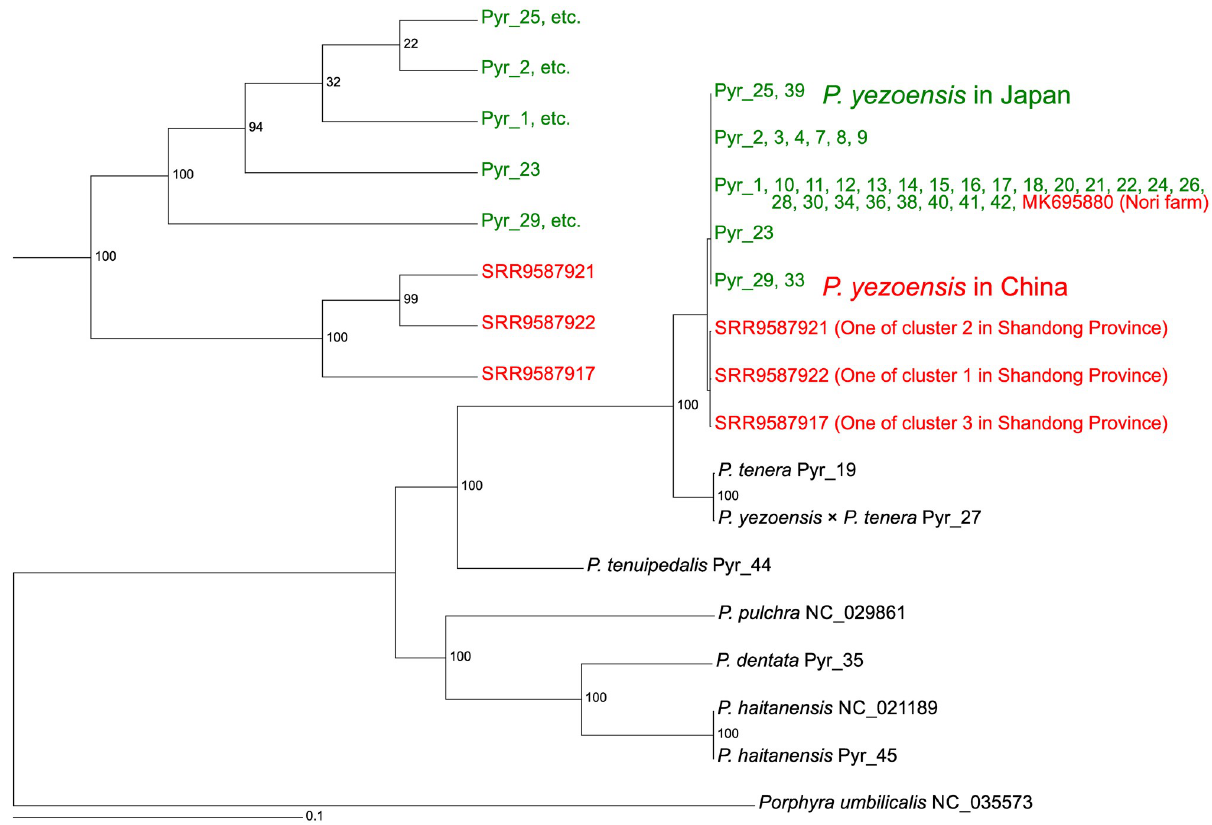
Fig 2. Phylogenetic tree of Pyropia species using long single section sequences of chloroplast DNA based on maximum likelihood reconstruction. The numbers at the nodes indicate bootstrap values (% over 1000 replicates). The scale bar shows the number of substitutions per site. The sequence of Porphyra umbilicalis was used as a root. The large figure is a phylogram showing the relationships among all the data used in this analysis. The small figure in the upper left is a cladogram showing the relationships for P . yezoensis only. Colors were used to distinguish between Chinese and Japanese P . yezoensis . The parameters for RAxML were as follows: -f = a, -x = 12,345, -p = 12,345, -N (bootstrap value) = 1,000, and -m = GTRGAMMAIX).